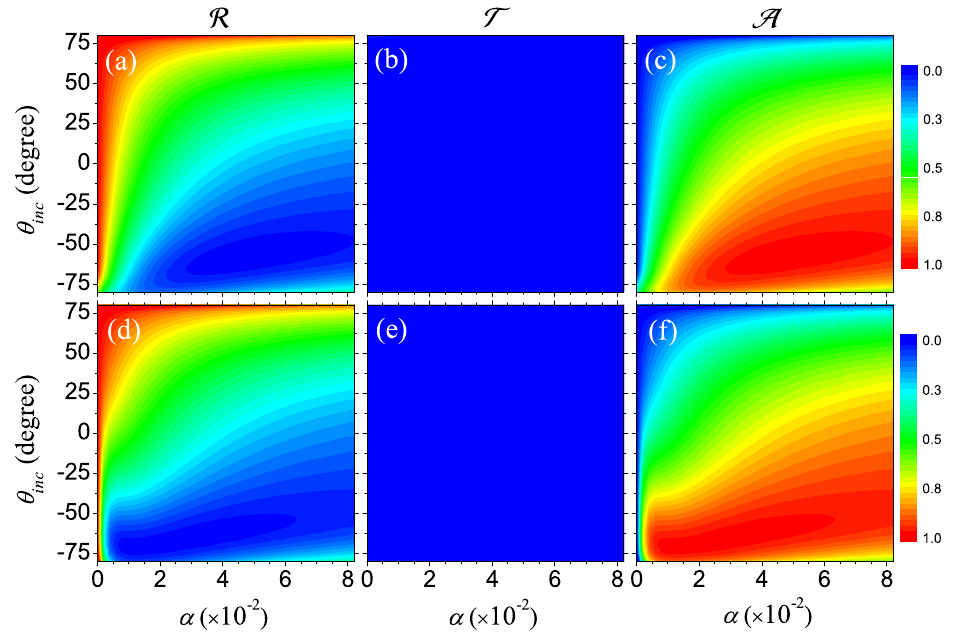
Figure 2. The reflectance ( a , d ), transmittance ( b , e ), and absorptance ( c , f ) are plotted as the functions of incident angle θ inc and damping factor α for the 5-layer MM slabs made up of pure ferrite rods ( a – c ) and hollow ferrite rods ( d – f ), respectively. The MM slabs of type I and type II have the same lattice separation a = 9 mm, two kinds of ferrite rods have the same outer radius r s = 2.25 mm, and the core radius of hollow ferrite rod is r c = 0.8 mm. The BMH is H 0 = 600 Oe and the working frequency is f = 4 GHz, locating at the vicinity of MSP